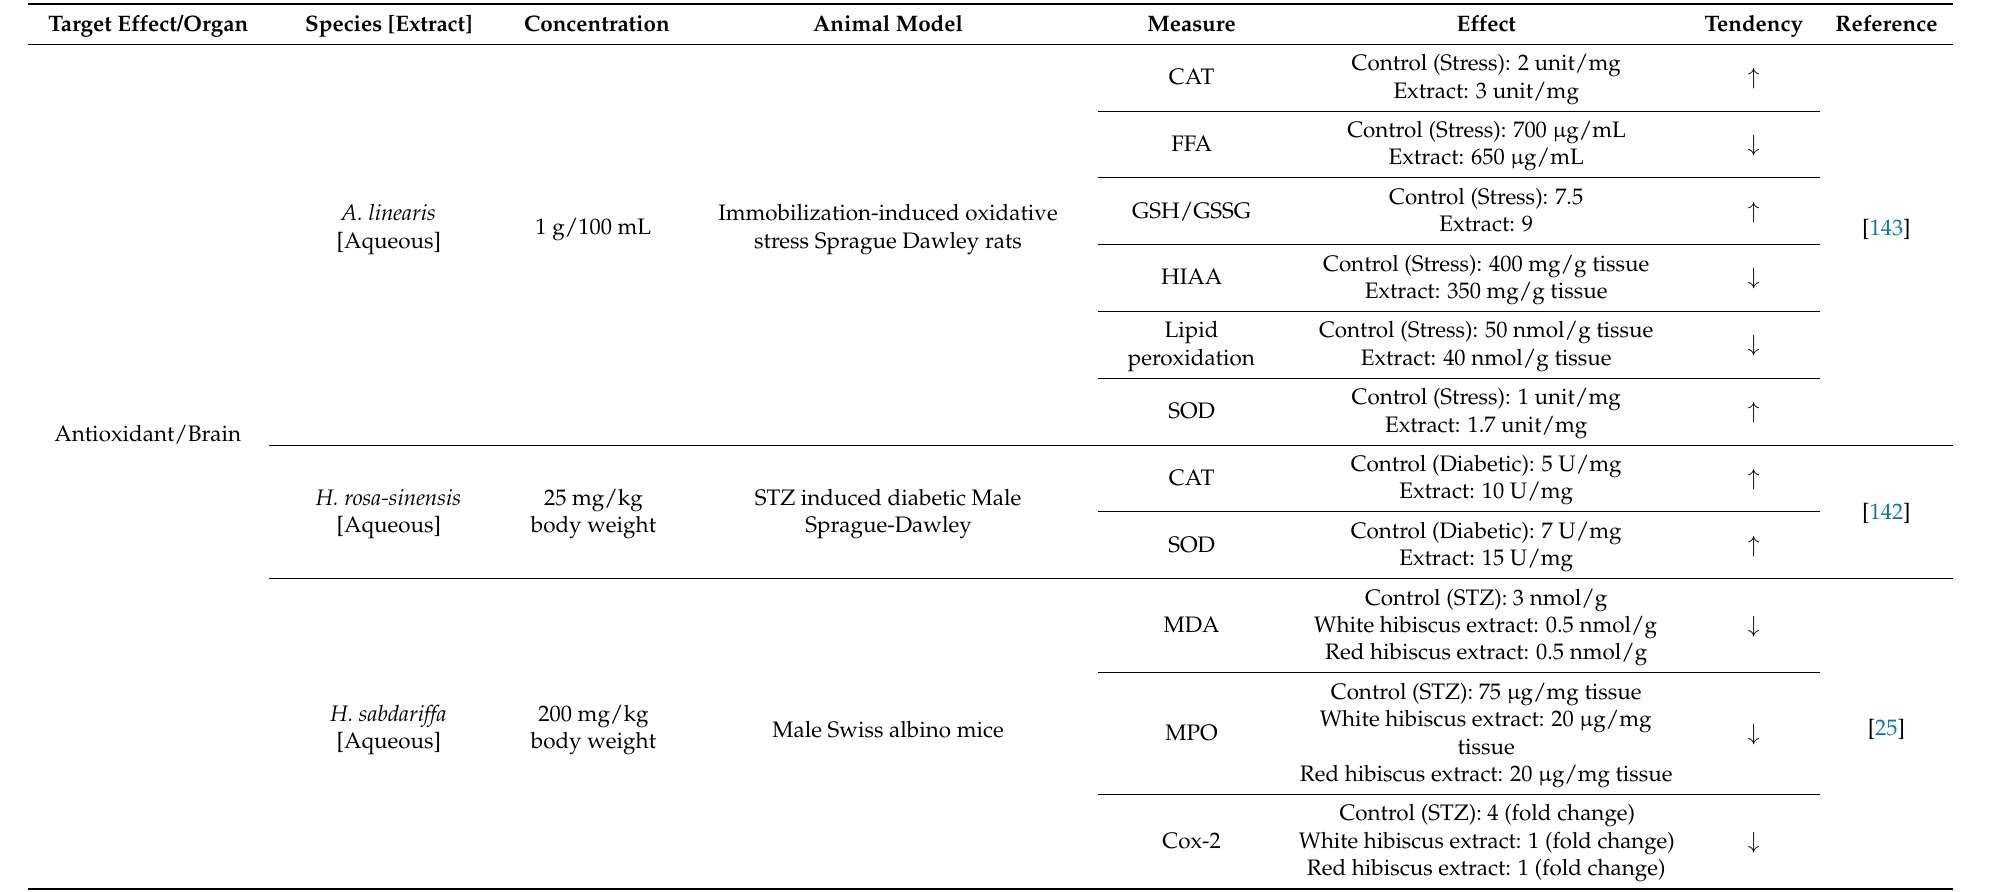
Table 4. In vivo antioxidant and anti-glycation effects of rooibos, hibiscus, yerba mate